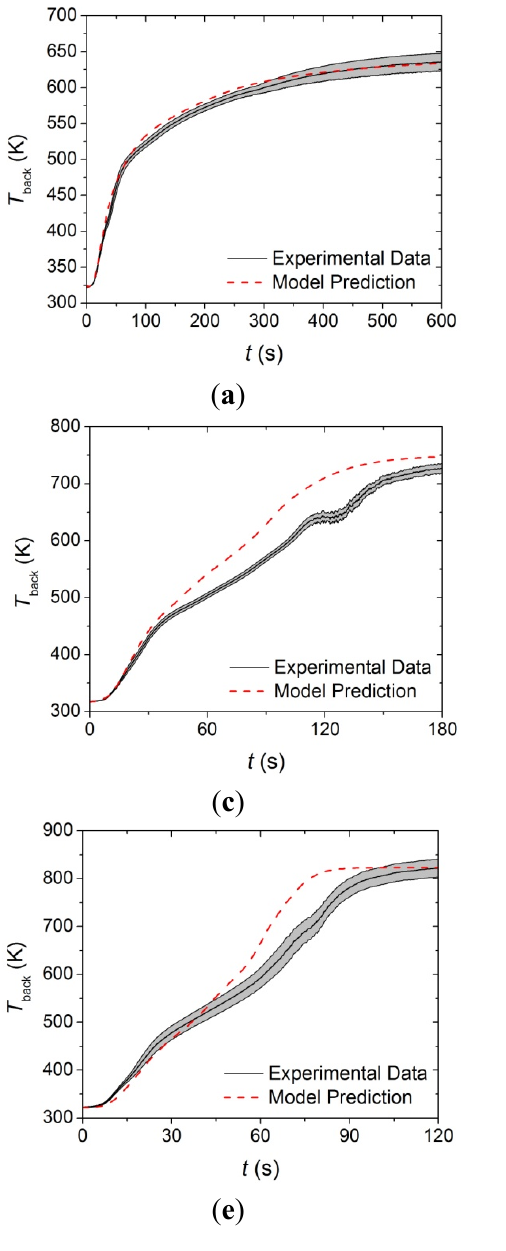
Figure 15. Experimental T back and MLR curve collected in CAPA tests and corresponding model predicted curve for the upper layer exposed to radiant fluxes of ( a ) and ( b ) 30 kW·m − 2 ; ( c ) and ( d ) 50 kW·m − 2 ; and ( e ) and ( f ) 70 kW·m − 2 . The shaded region and error bars correspond to two standard deviations of the mean experimental data.